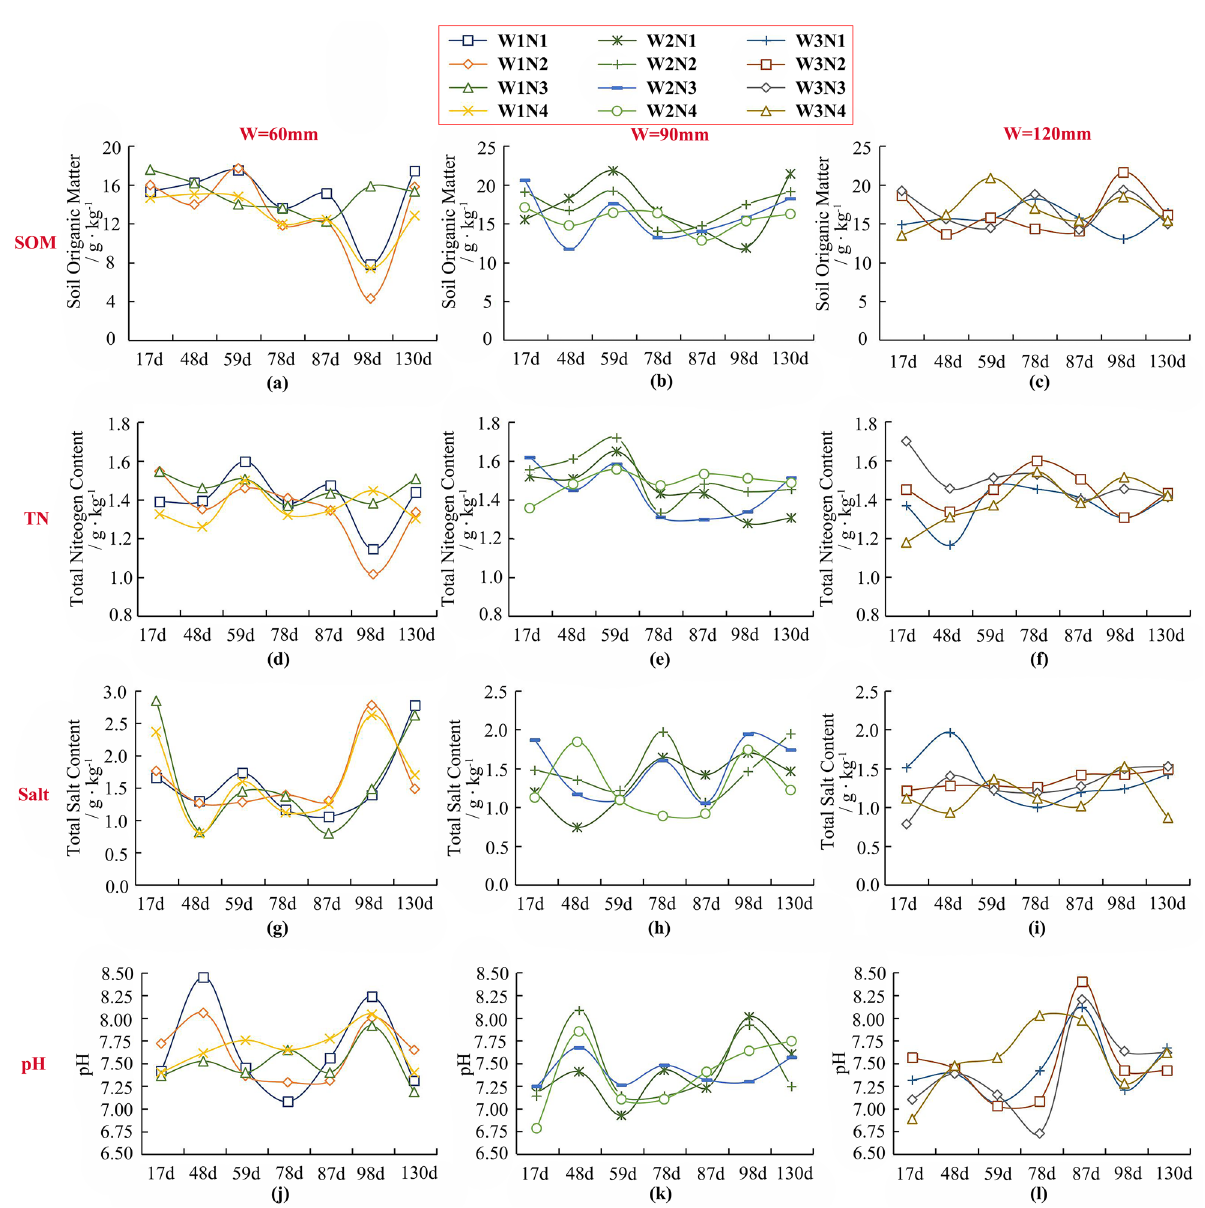
Figure 3. Changes in soil organic matter, total nitrogen, salinity, and pH under different treatments over time (a case study of